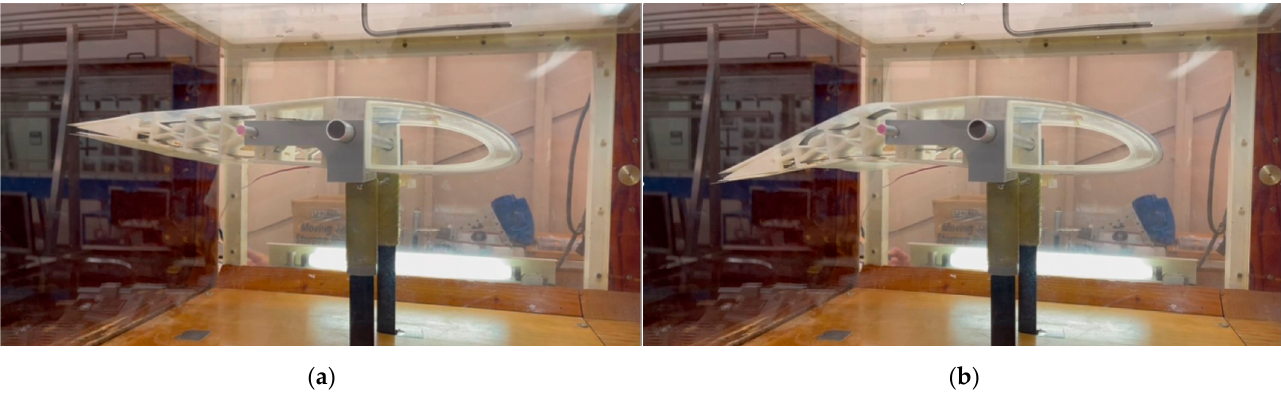
Figure 20. Wind tunnel testing: ( a ) uncambered model, ( b ) cambered at 35 m/s airspeed.